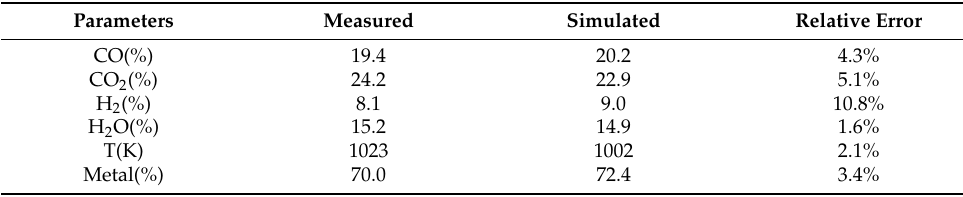
Table 6. Comparison between measured and simulated results.